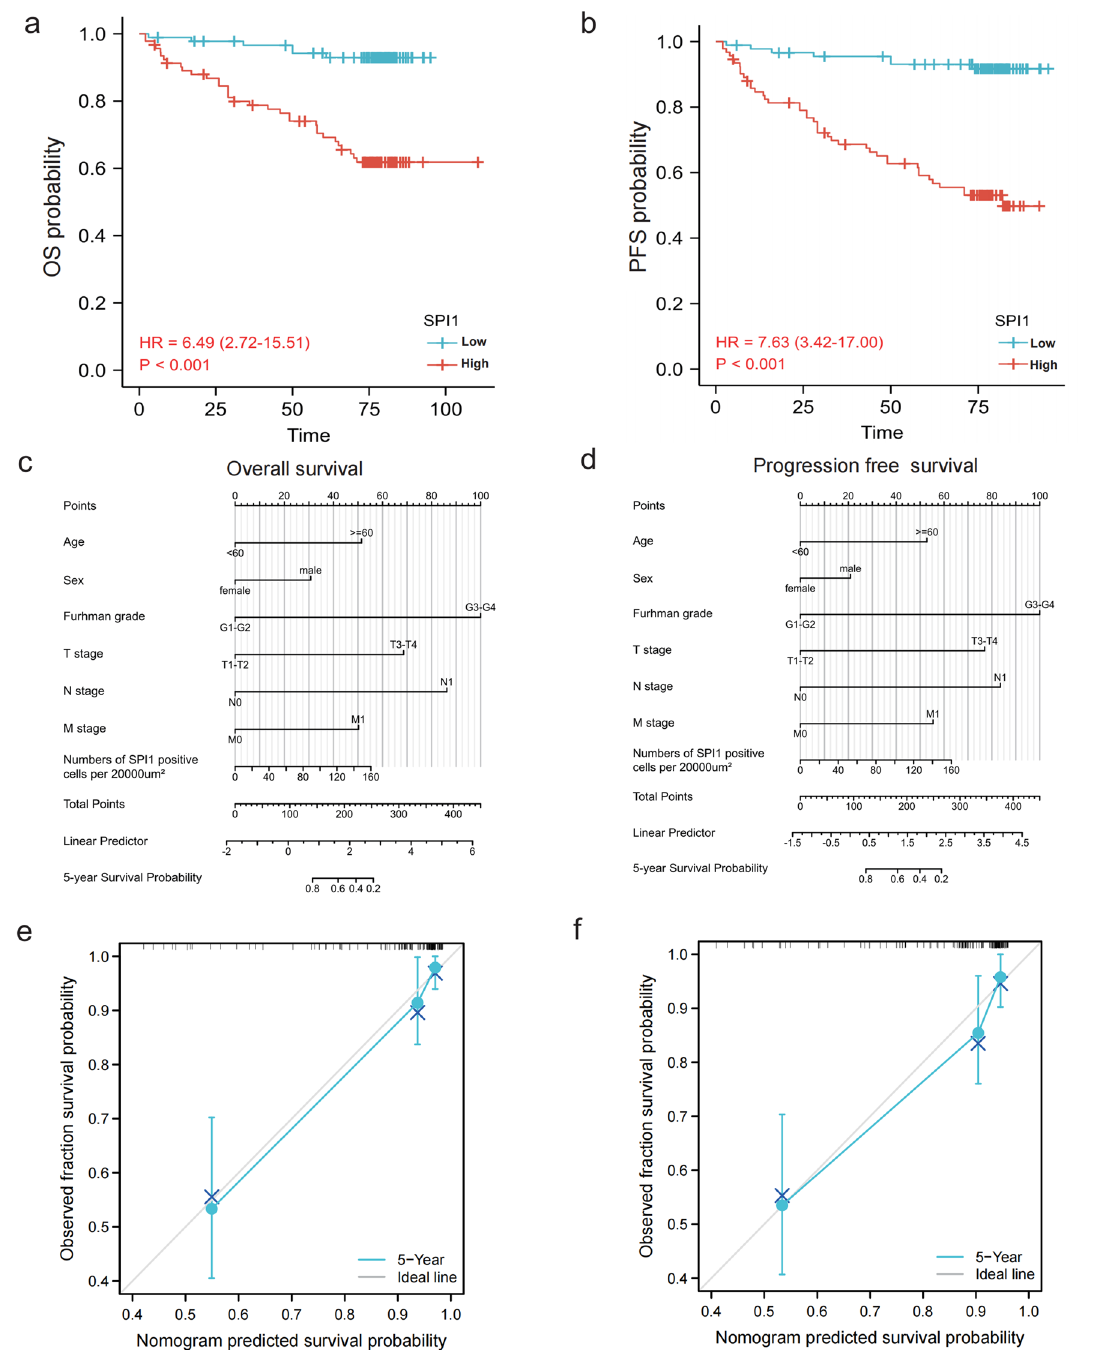
Fig. 3 Prognostic value of SPI1 . a , b High SPI1 expression level predicted poor OS ( a ) and PFS b in ccRCC. c , d OS ( c ) and PFS ( d ) predictions of patients with ccRCC at five years after surgery are shown in nomograms. e , f Calibration plots of the nomograms for the prediction of five- year OS e and PFS f . ccRCC clear cell renal cell carcinoma; OS overall survival; PFS progression-free